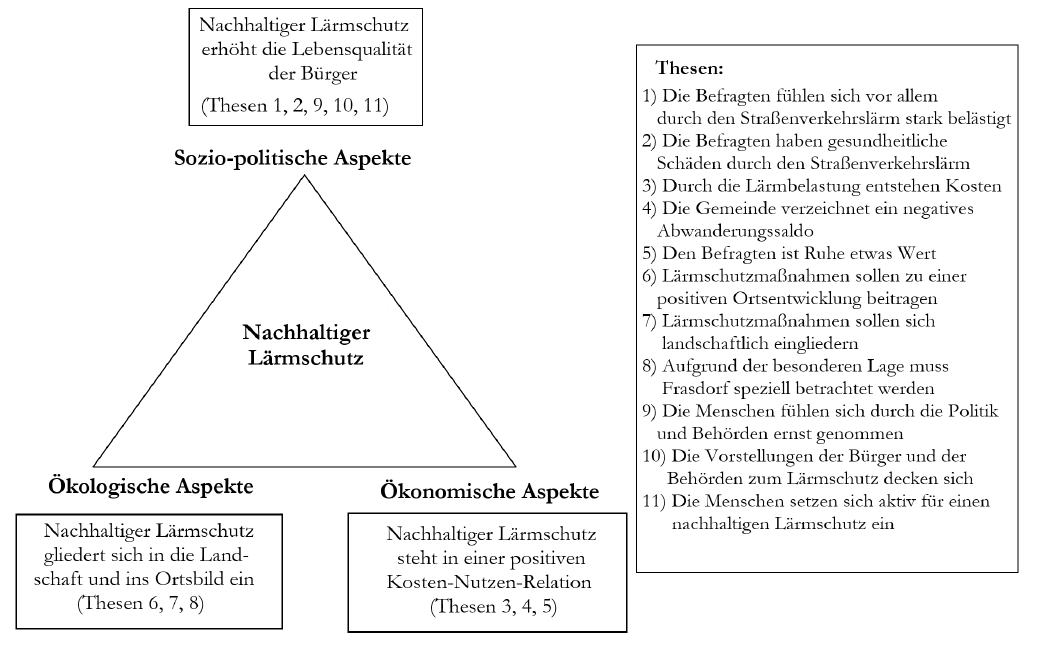
Figure 2: Hypotheses for the citizen and expert